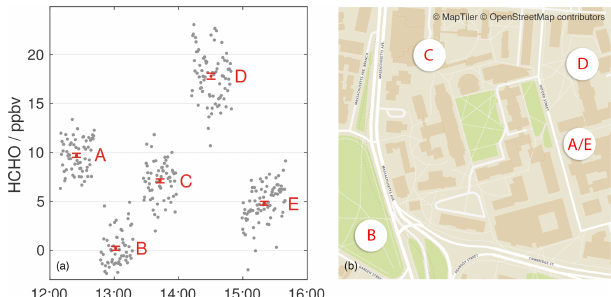
Figure 7. (a) Aeris sensor (operating in HAPP fit HDO mode) used as a HCHO personal exposure monitor for several hours on a single battery charge around the Harvard campus in Cambridge, MA. All times EDT. Locations included (A) office space ( N = 64 points), (B) urban park ( N = 55 points), (C) cafeteria ( N = 62 points), (D) museum space ( N = 75 points), and (E) lab space ( N = 82 points). The data from HAPP fit is displayed with the raw 30s data (grey) as well as the average and ± 1 σ standard deviation of the mean for each location (red). Data is not shown when the sensor was trans- ported from one location to another. (b) Map data © OpenStreetMap contributors. Schema from OpenMapTiles.org (MapTiler and Open- StreetMap Contributors,